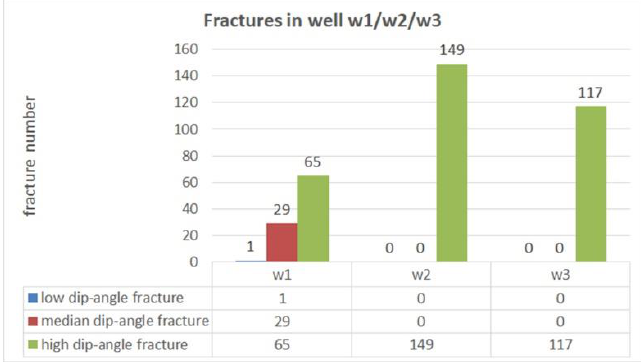
Figure 5. Fractures in wells w1/w2/w3.